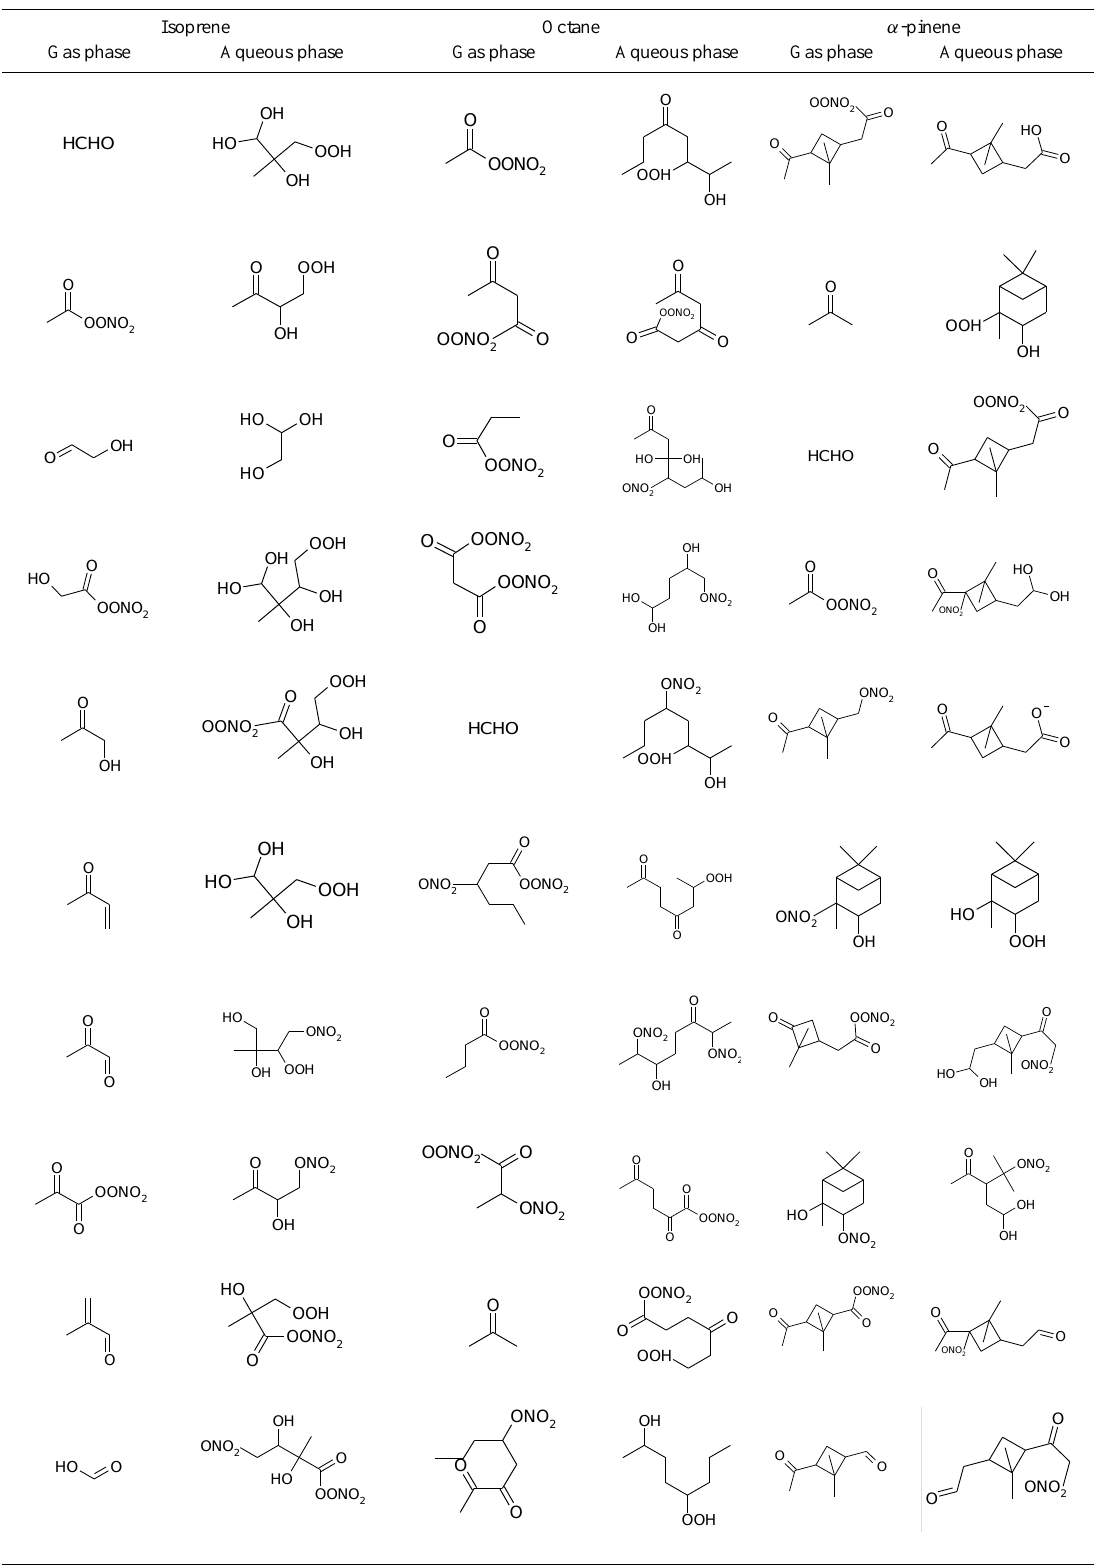
Table 2. Top ten species simulated in gas and aqueous phase for a cloud liquid water content and for intermediate NO x conditions at N τ = 10.